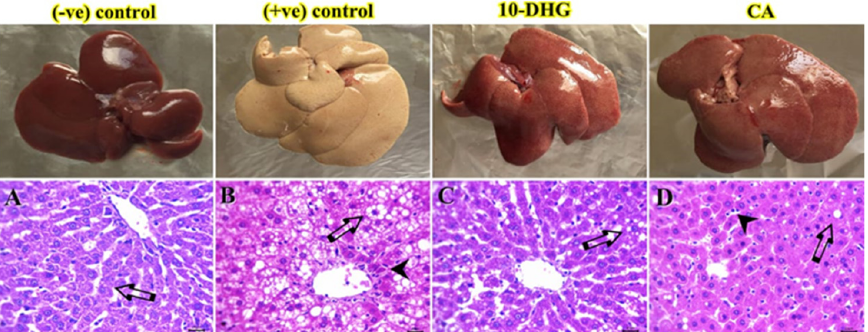
Figure 5. Effect of caffeic acid and 10-dehydrogengerdione on liver histology and morphology. Photomicrograph of H&E-stained sections from liver (scale bar 20 μ m) showing: ( A ) normal architectures of hepatocytes (arrow), central vein and sinusoids in (-ve) control group; ( B ) intense lipidosis beside presence of foamy cells with centrally located nuclei (arrow) and apoptotic cells (arrowhead) in (+ve) control group; ( C ) unicellular hepatic lipidosis (arrow) in CA; ( D ) fatty change in individual cell (arrow), as well as lymphocytic infiltrates within some sinusoids (arrowhead) in 10-DHG.